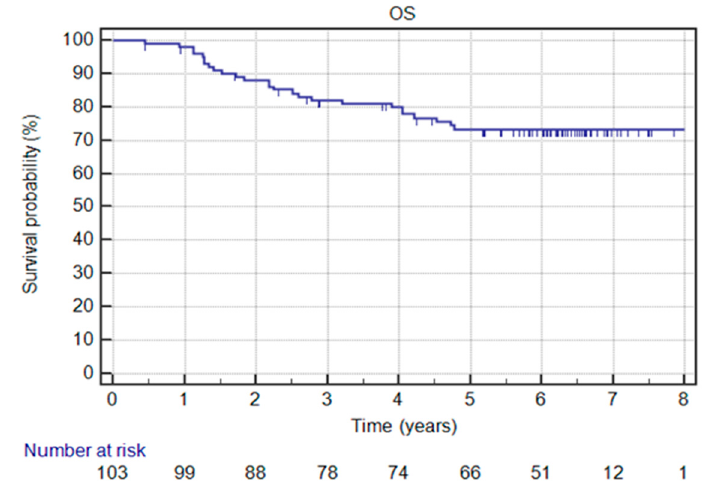
Figure 6. Overall survival (OS) in the whole